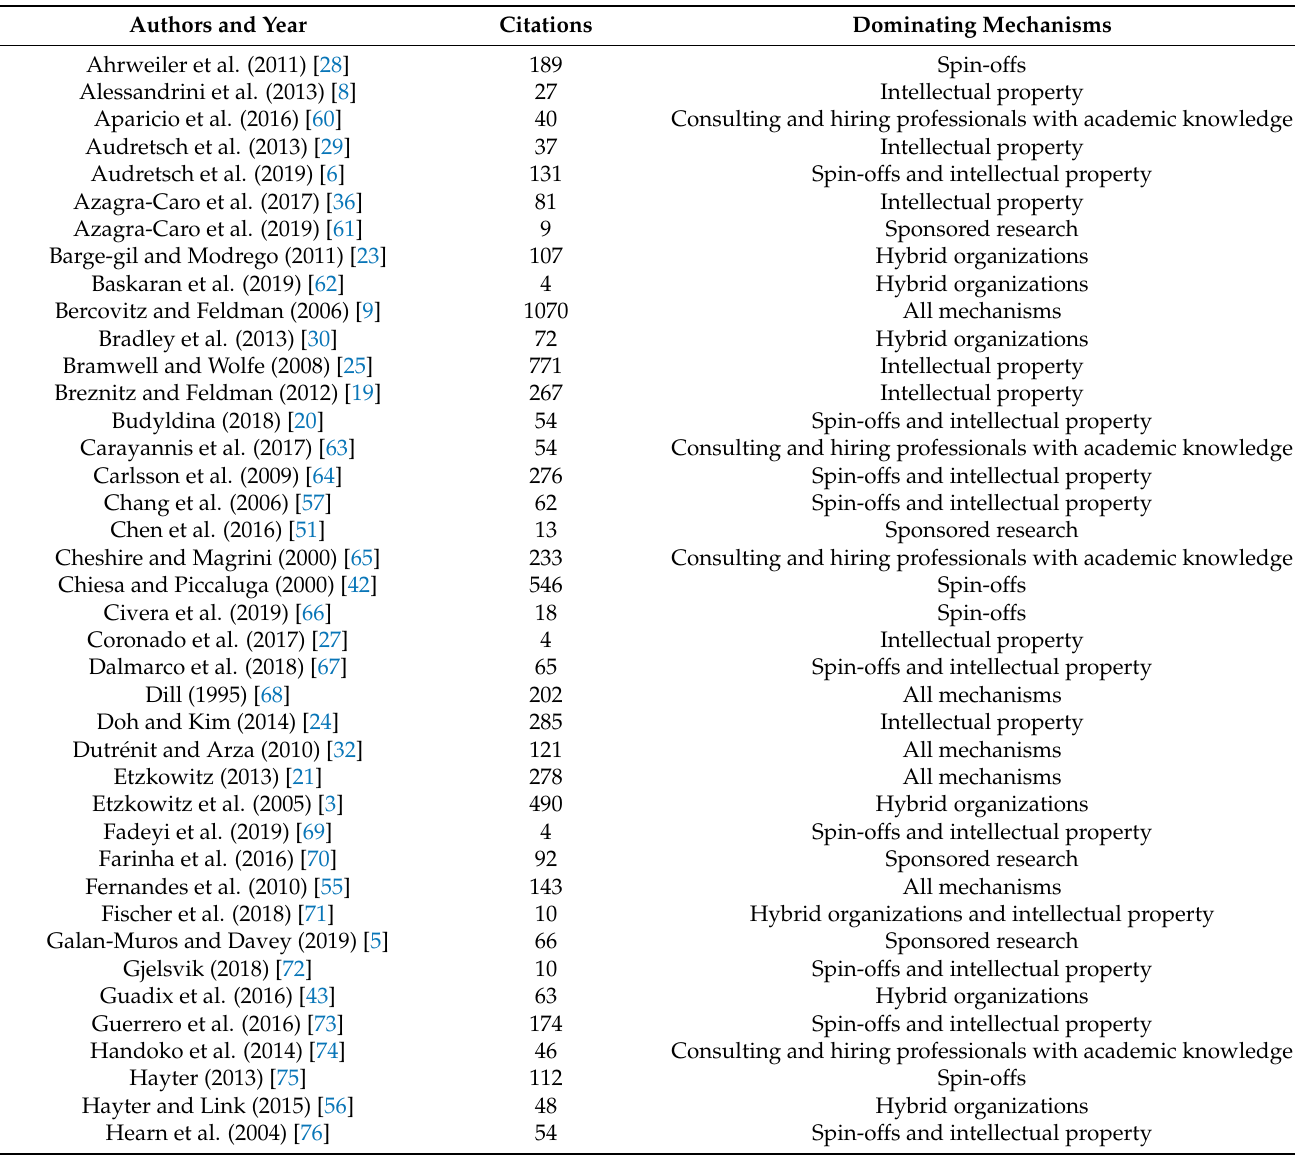
Table A3. Number of citations and dominating